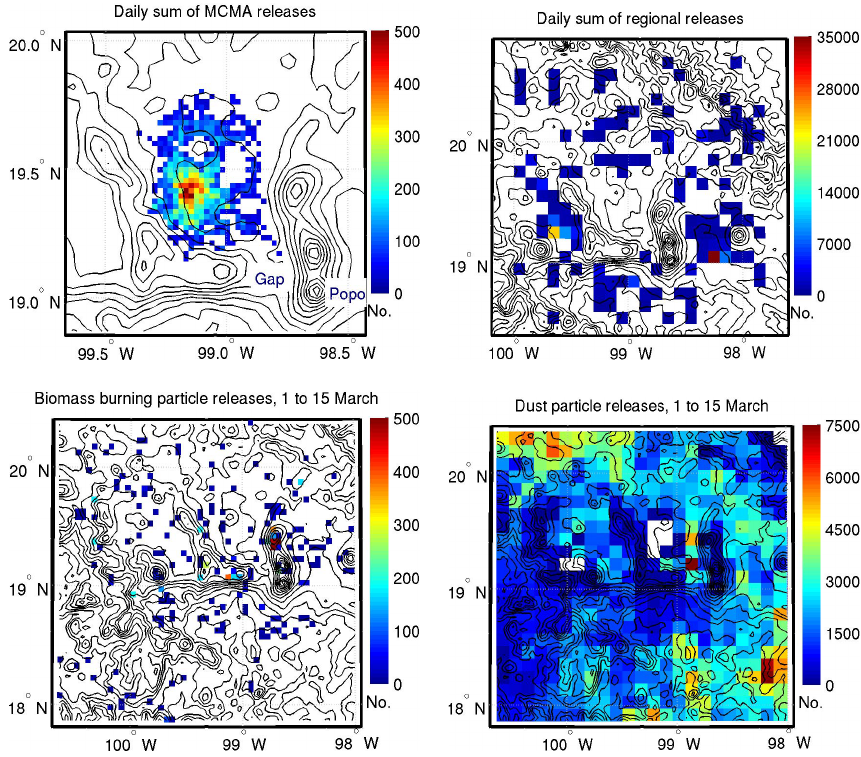
Fig. 1. Maps of particles released for urban and regional emissions (daily sum) and biomass burning and dust emissions (sum from 1 to 15 March). Terrain contour lines shown every 250m. Basin map also shows the location of the mountain gap and the Popocatepetl volcano discussed in